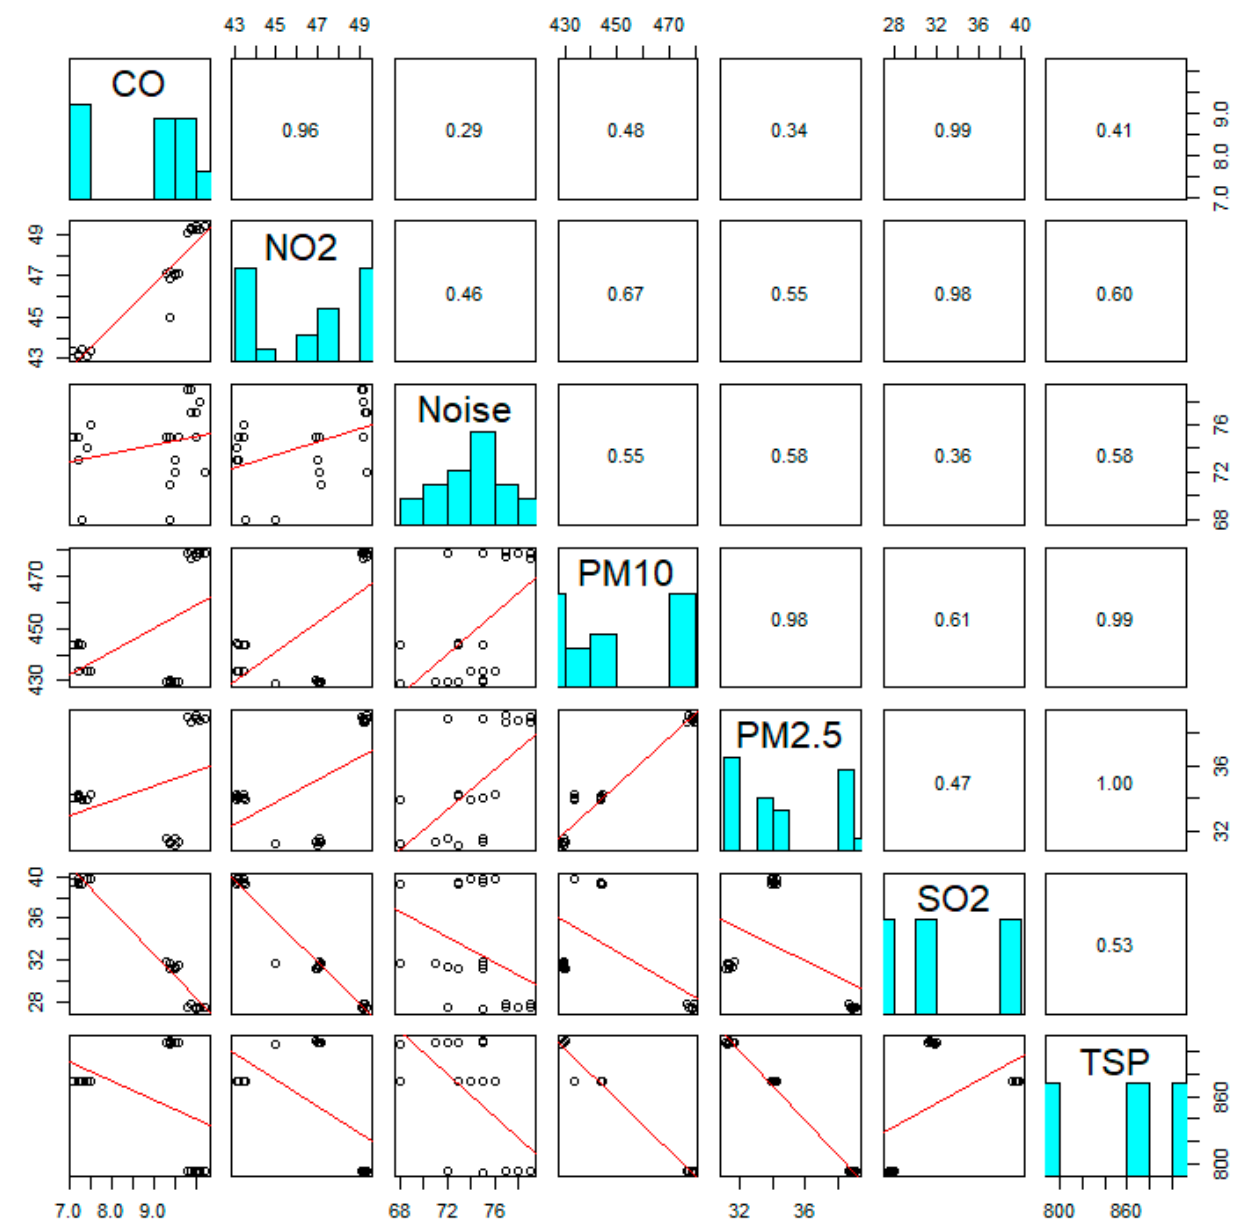
Figure 2. Correlation between different parameters with particulate matter in Faisalabad.